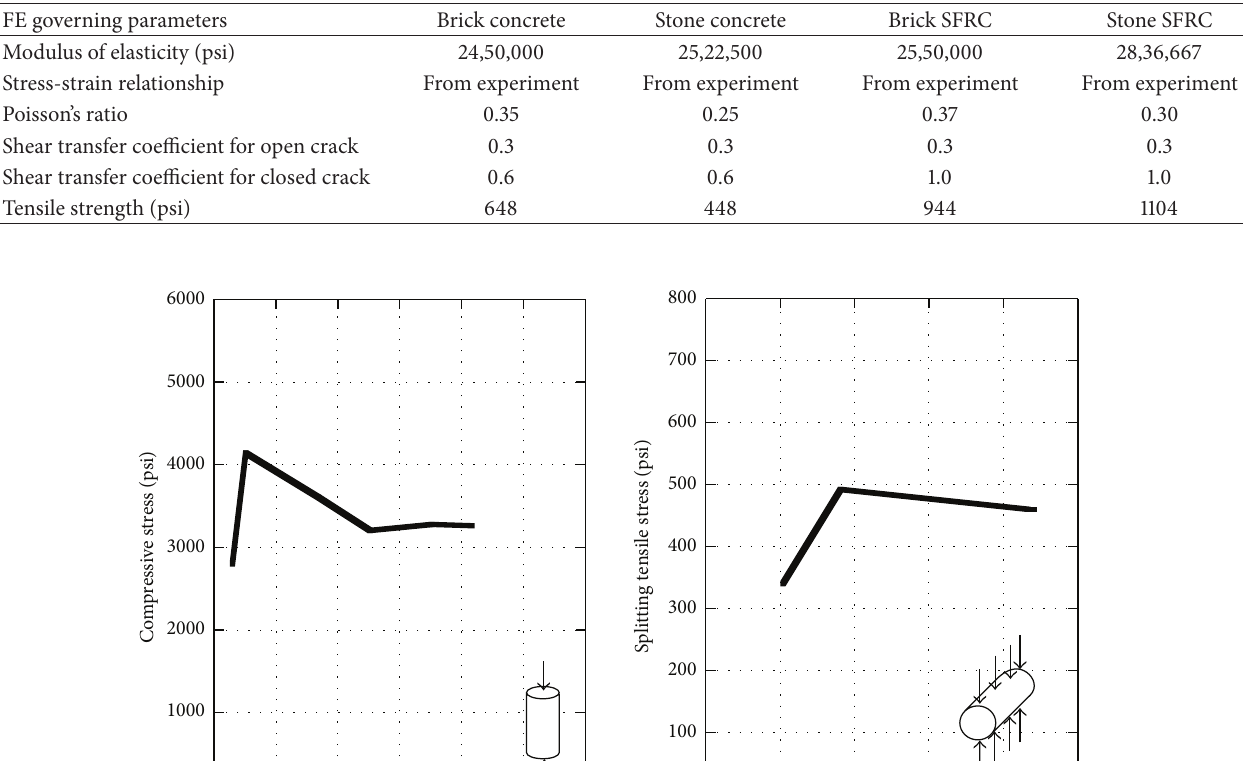
Table 2: FE governing parameters.